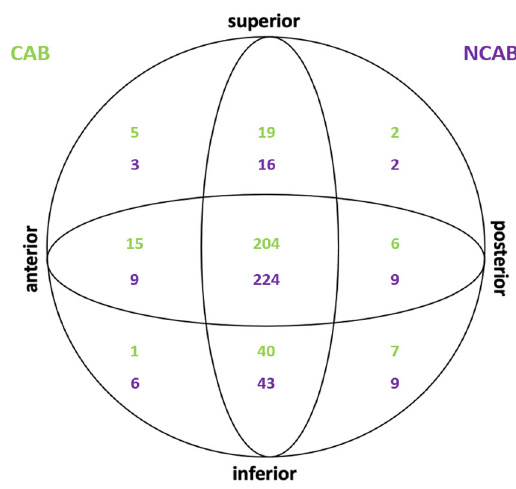
Figure 2. Blade positions of patients without mechanical failure.